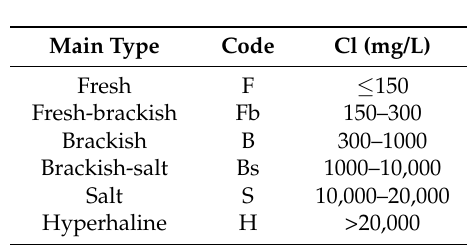
Table 3. Water type classification [65].